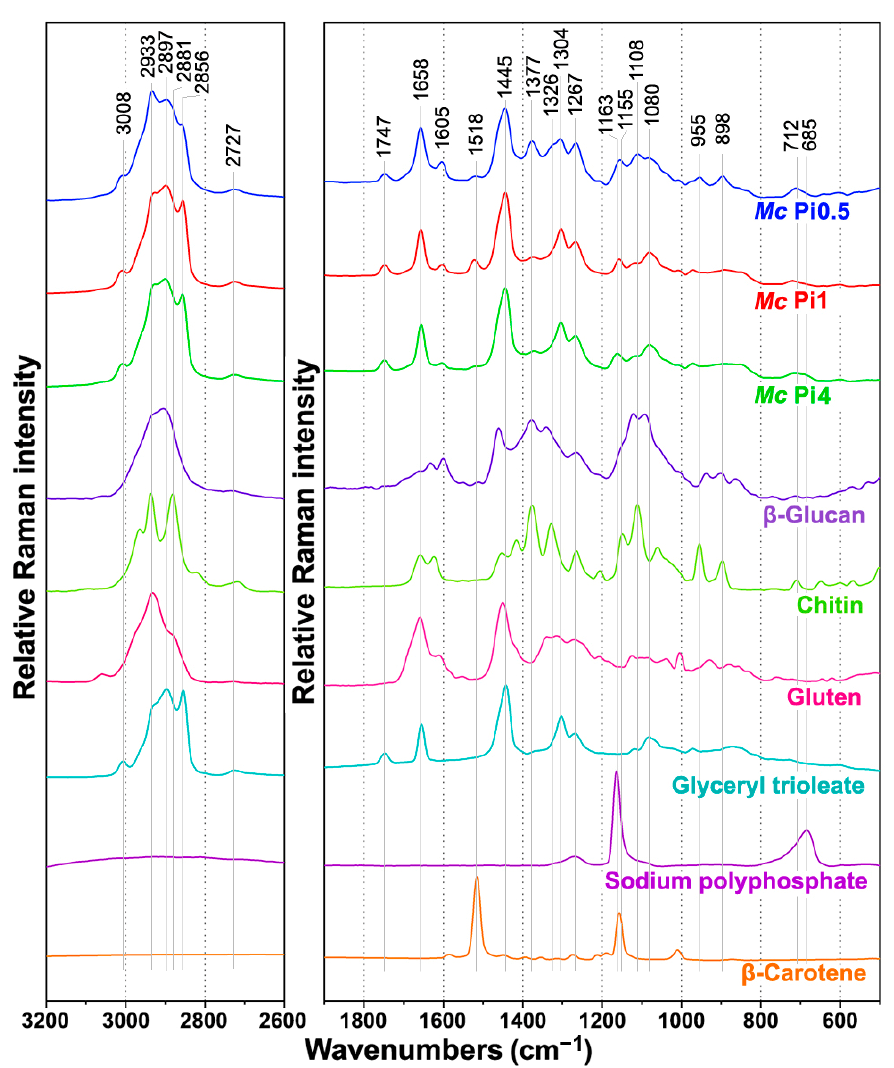
Figure 5. FT-Raman spectra of Mucor circinelloides ( Mc ) strain VI 04473 cultivated under Ca1 condi- tions and three different phosphate concentrations, and of six reference compounds: β -glucan, chitin, gluten, glyceryl trioleate, sodium polyphosphate, and β -carotene. All spectra were preprocessed and plotted with offset for better viewing. Table 1. Assignments of infrared and Raman bands: str.—stretching and def.—deformation [37–39,44,59,61,74,75] .